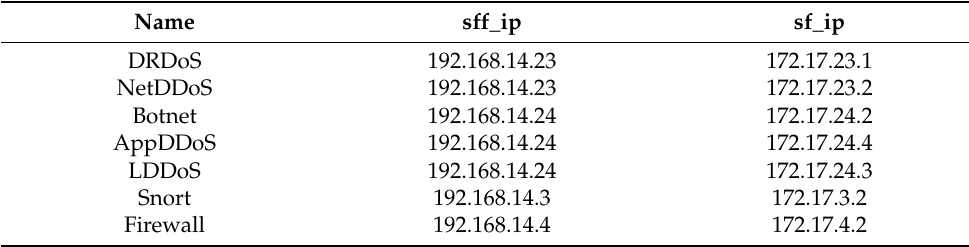
Table 5. Service Function Registry Information.